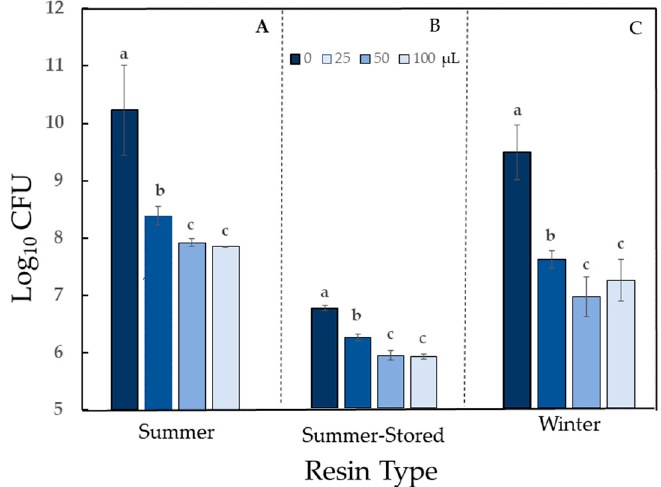
Figure 5. Antimicrobial activity of autoclaved Sv resin against Erwinia amylovora . ( A ) Resin collected in summer and evaluated within 72 h. ( B ) Resin collected in summer and stored at –20 °C for 6 months before evaluation. ( C ) Resin collected in winter and evaluated within 72 h. Treatment doses (0, 25, 50, and 100) are volumes of suspended resin ( µ L) in 300 µ L. For each resin type, bars appearing with the same letter are not di ff erent according to Tukey’s test ( P < 0.05). Data shown are arithmetic means + standard